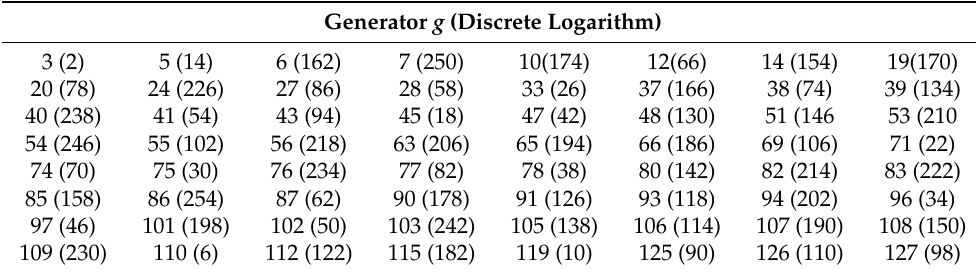
under different 257